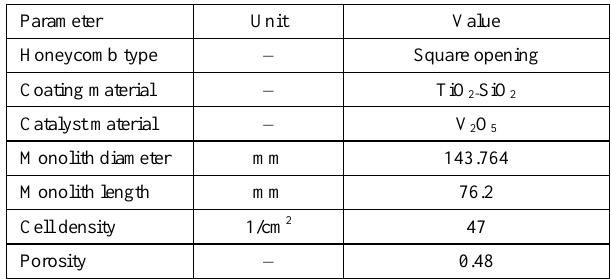
Fig. 3. Probes positions on exhaust piping modeled and final application Table 1. SCR unit dimension and properties